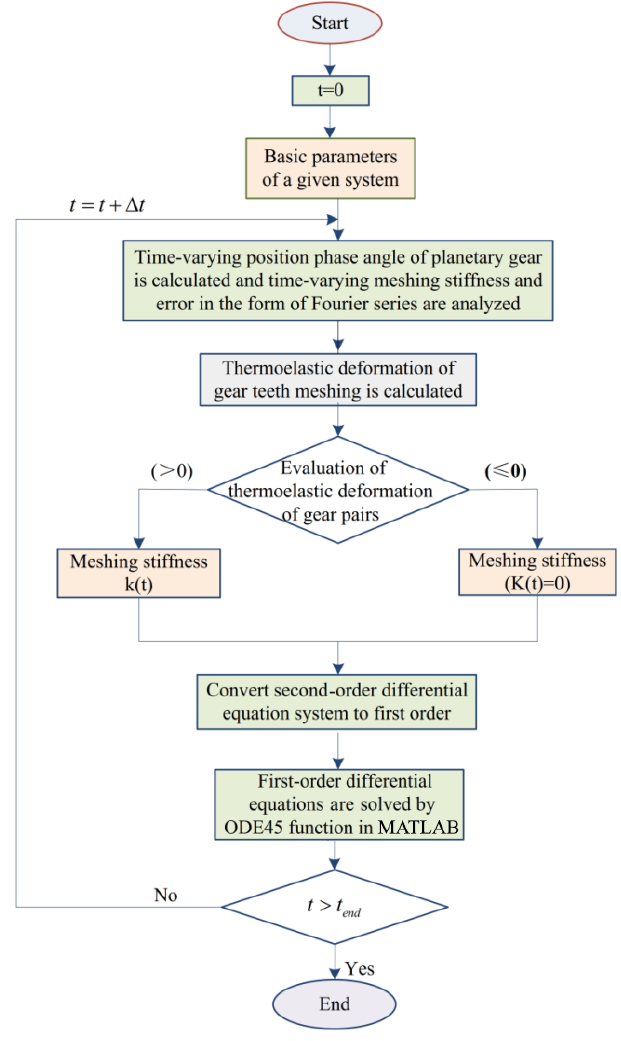
Figure 3. Flowchart of the numerical integral calculation system